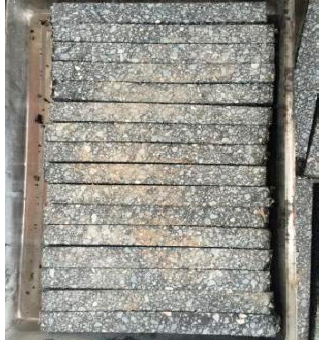
Figure 2. Specimen beams.